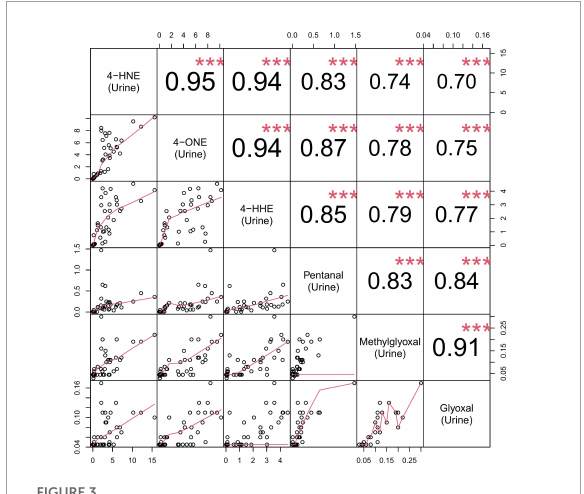
FIGURE3 Correlation matrix chart for urine reactive aldehydes. Top right –the (absolute) value of the correlation (R) using Spearman’s rho with stars of significance. Bottom left –the bivariate scatterplots, with black circles indicating points and red fitted line. Correlations ≥ 0.7 were considered significant. Stars of significance *** p < 0.001.